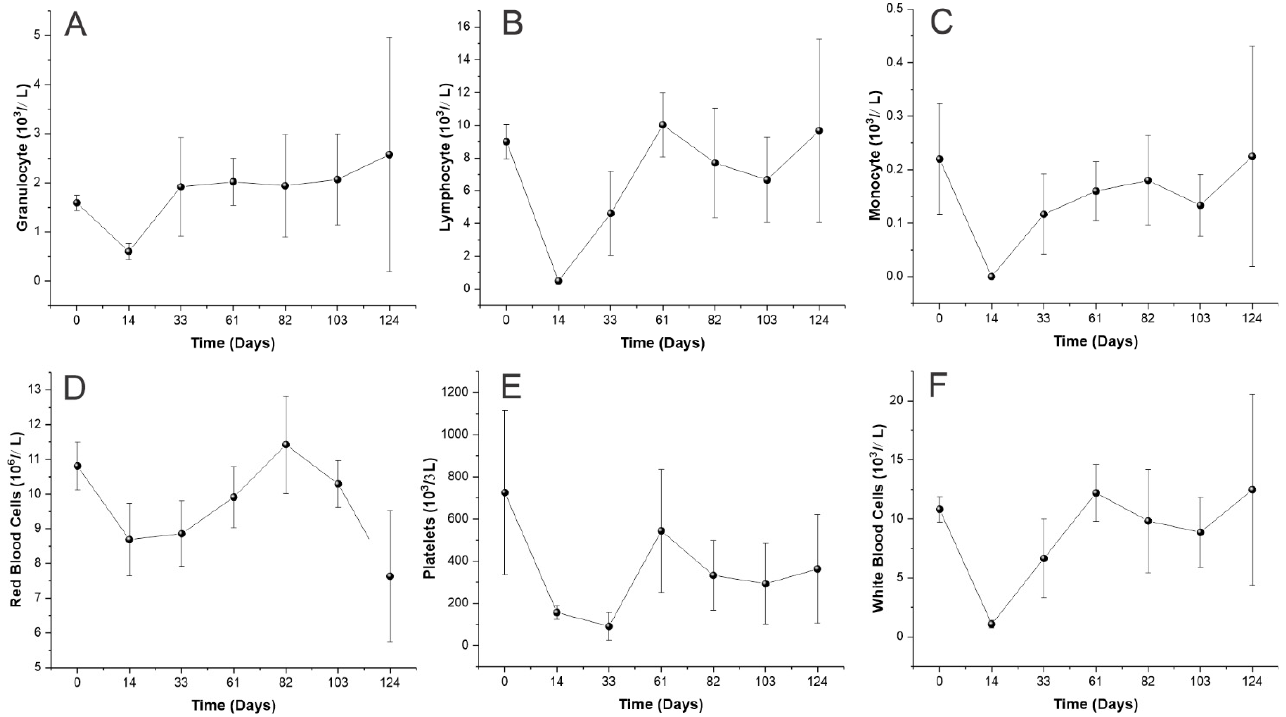
Figure 5. Blood count for hematopoietic reconstitution evaluation. ( A – F ) Variation in the number of granulocytes, lymphocytes, monocytes, red blood cells, platelets, and white blood cells, respectively, throughout 124 days after